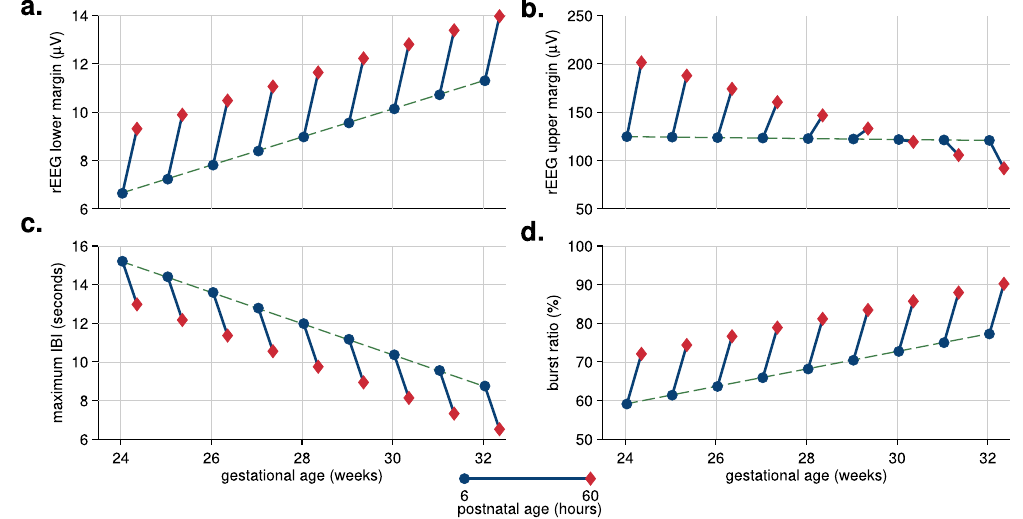
Figure 3. Visualising the temporal trajectories in context of intra-uterine maturation: plots of postnatal-age fixed-effect (as dots-to-diamonds lines) at selected gestational ages. Four features, 2 from the range-EEG (rEEG) in ( a , b ) and 2 features of the burst annotation ( c , d ); maximum IBI (inter-burst interval) refers to the 95th centile of the IBI. All features are dependent on time and gestational age; rEEG upper margin in ( b ) is also dependent on time-by-gestational interaction.